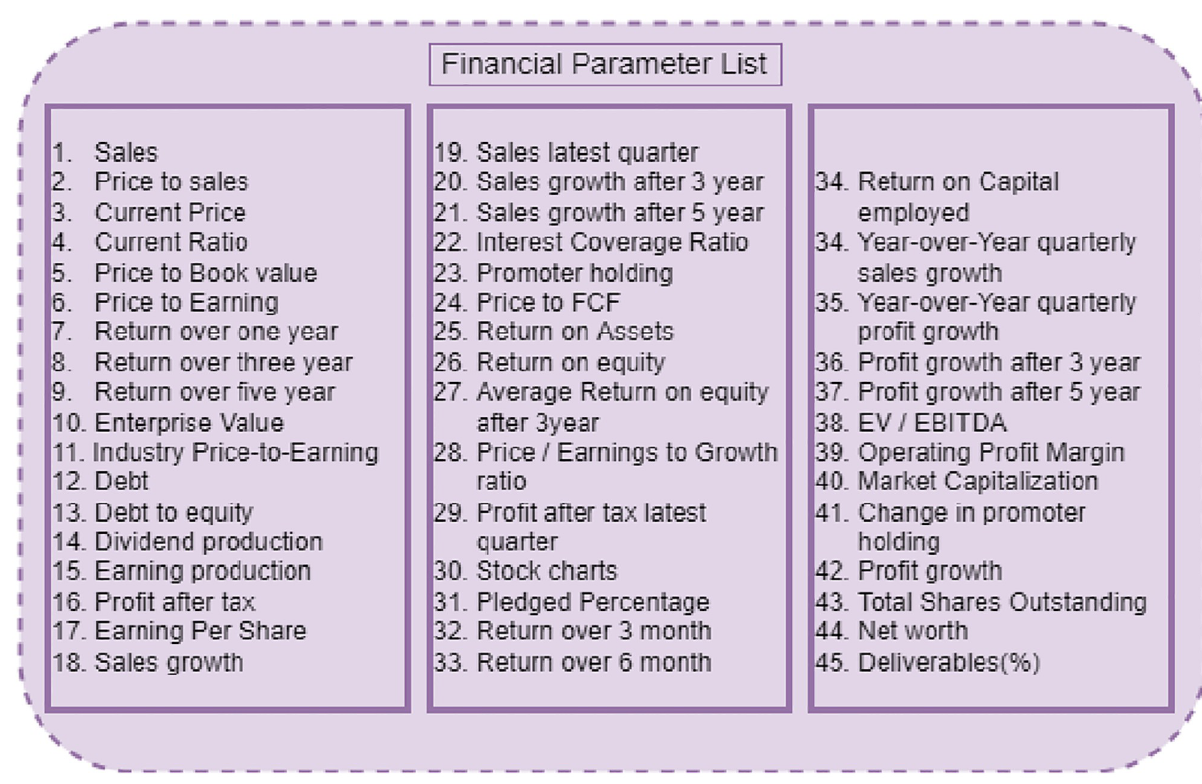
Fig 3. Financial parameters of the stock